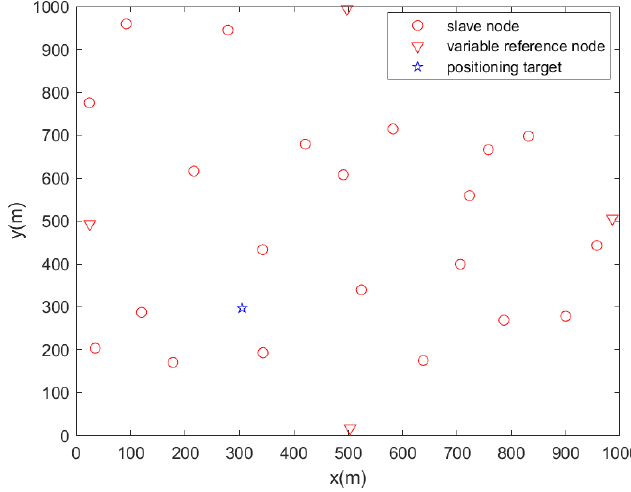
Figure 7. The schematic diagram of the positioning system.